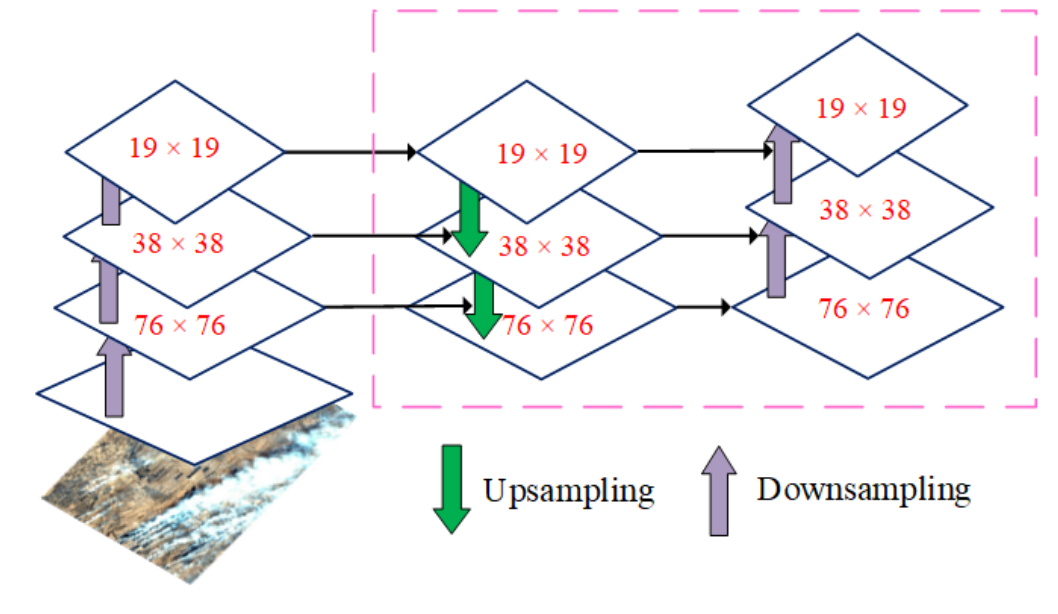
Figure 9. FPN + PAN structure diagram.